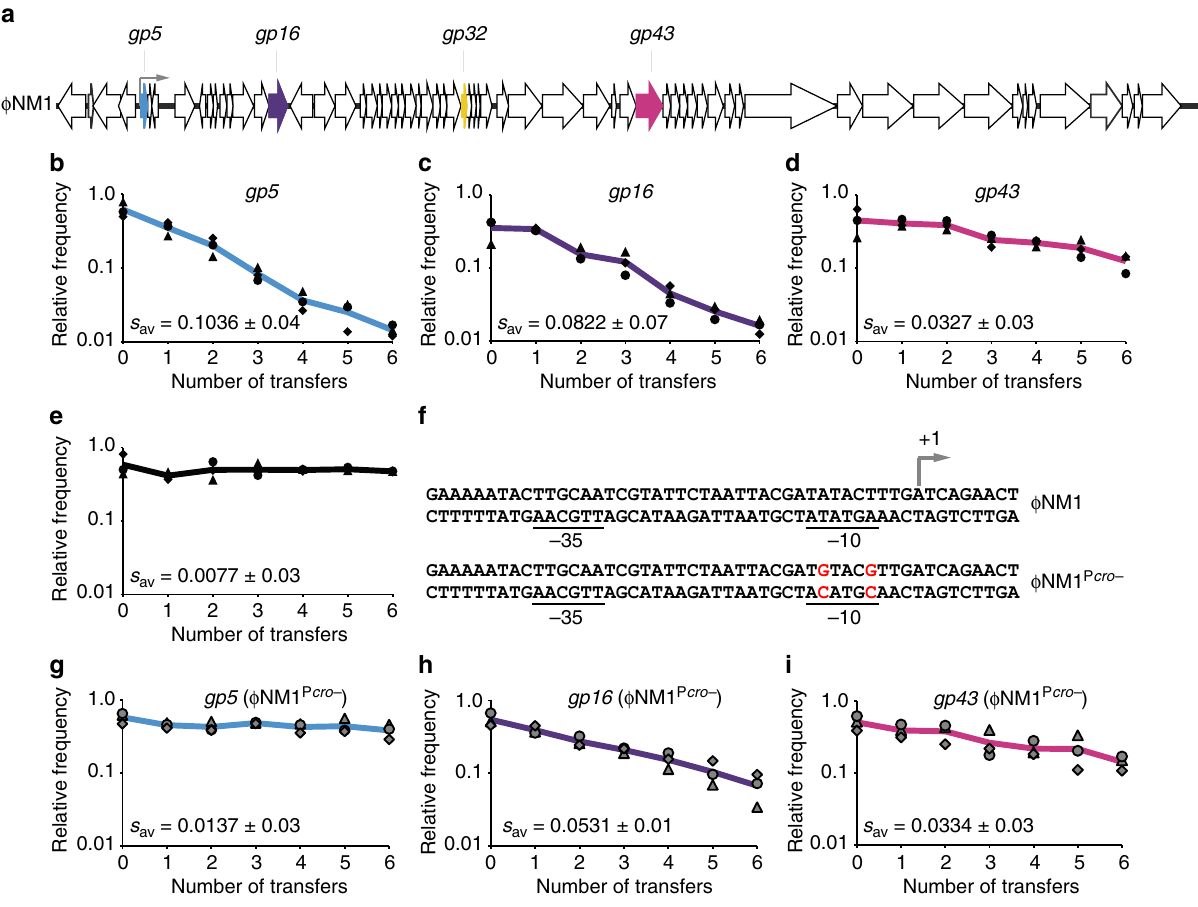
Fig. 1 Incomplete prophage tolerance by type III-A systems can be licensed by prophage-internal promoter activity. a Schematic representation of the integrated Φ NM1 prophage genome. The gp5 , gp16 , gp32 , and gp43 open reading frames are colored to denote inclusion of a target sequence for one or more spacers tested in this work. Gray bent arrow indicates the position of Φ NM1 ’ s early lytic promoter (P cro ). b – d Pairwise competition experiments for three perfectly matching spacers that license conditional tolerance of Φ NM1. In each case, an Erm R -marked control lysogen harboring the parent vector with non-targeting spacers was competed against a Tet R -marked conditionally tolerant lysogen. Relative frequencies ( y -axis) are plotted against